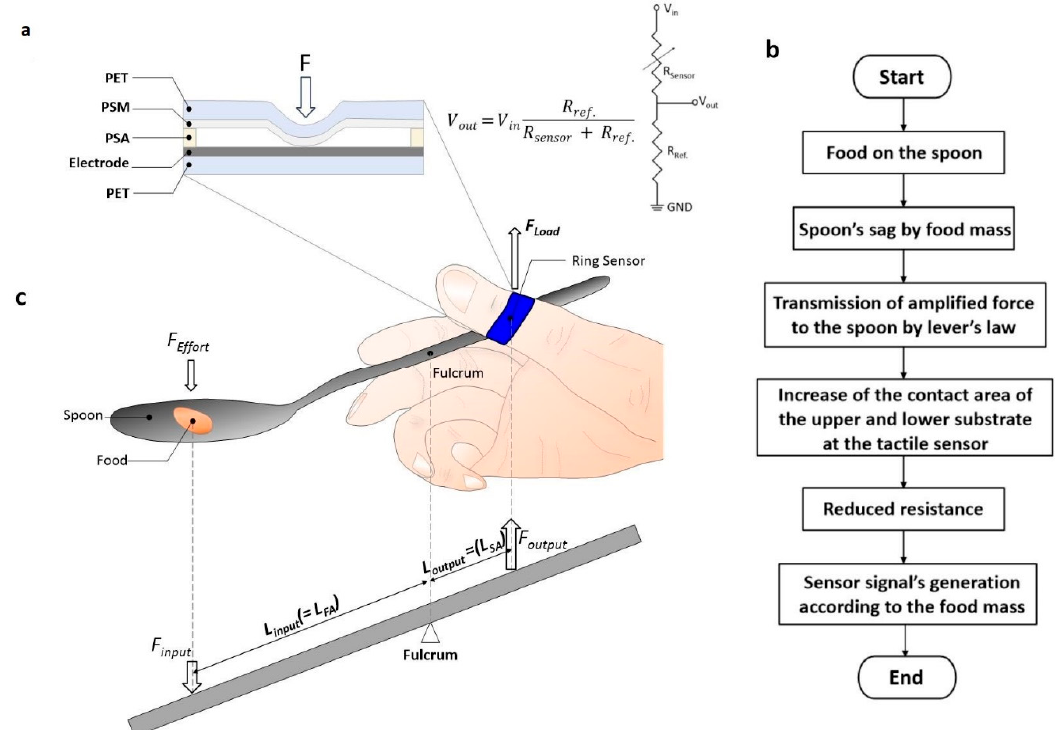
Figure 2. Schematic illustration of the ring-type sensing system's principle. ( a ) Schematic illustration of the force-sensitive layers of the ring sensor with voltage in-and-out relation. ( b ) Flow chart of the operation mechanism. ( c ) Schematic diagram of the ring-type biosensor using the first-class lever mechanism: L input means the length of food arm ( L FA ) and L output means the length of the sensor arm ( L SA ).